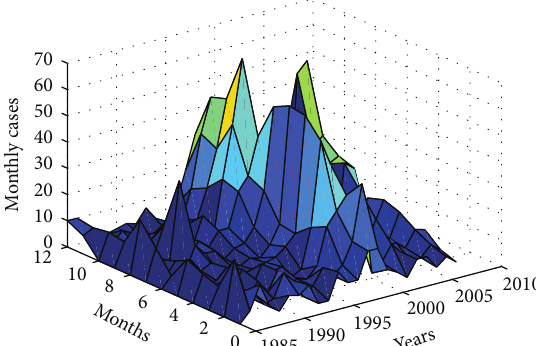
Figure 2: Surface based on cases of American Tegumentary Leish- maniasis in Department of Or´an, Salta, Argentina. The surface shows longitudinal evolution of diseases in the twenty-three years (years) and transversal changes corresponding to monthly patterns